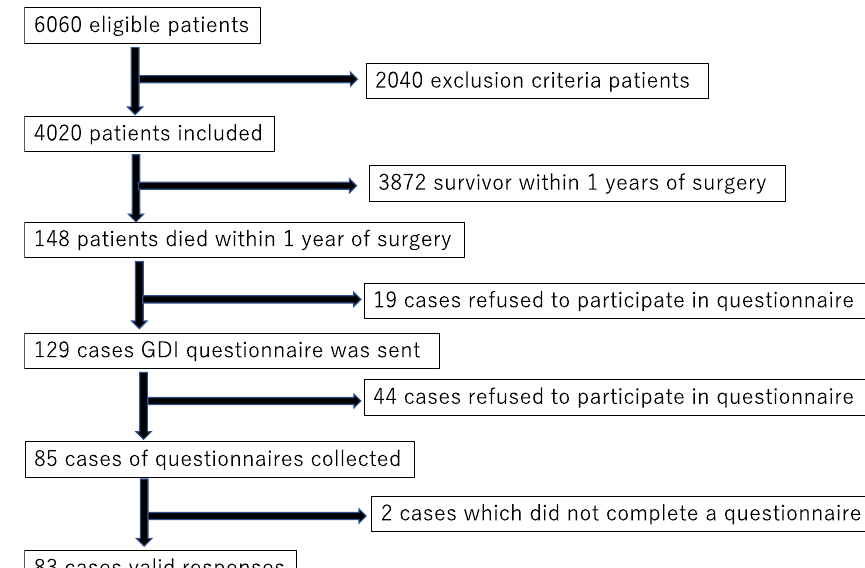
Fig. 1 Patient flowchart for study inclusion and exclusion